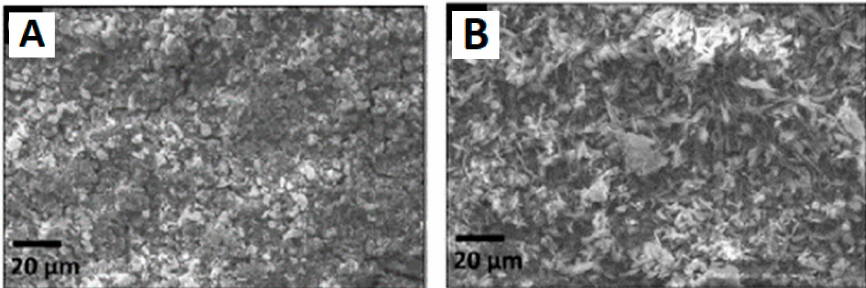
Figure 23. SEM micrographs of the geopolymer (obtained by alkaline activation) coating ( A ) and of the geopolymer (obtained by acidic activation) coating ( B )